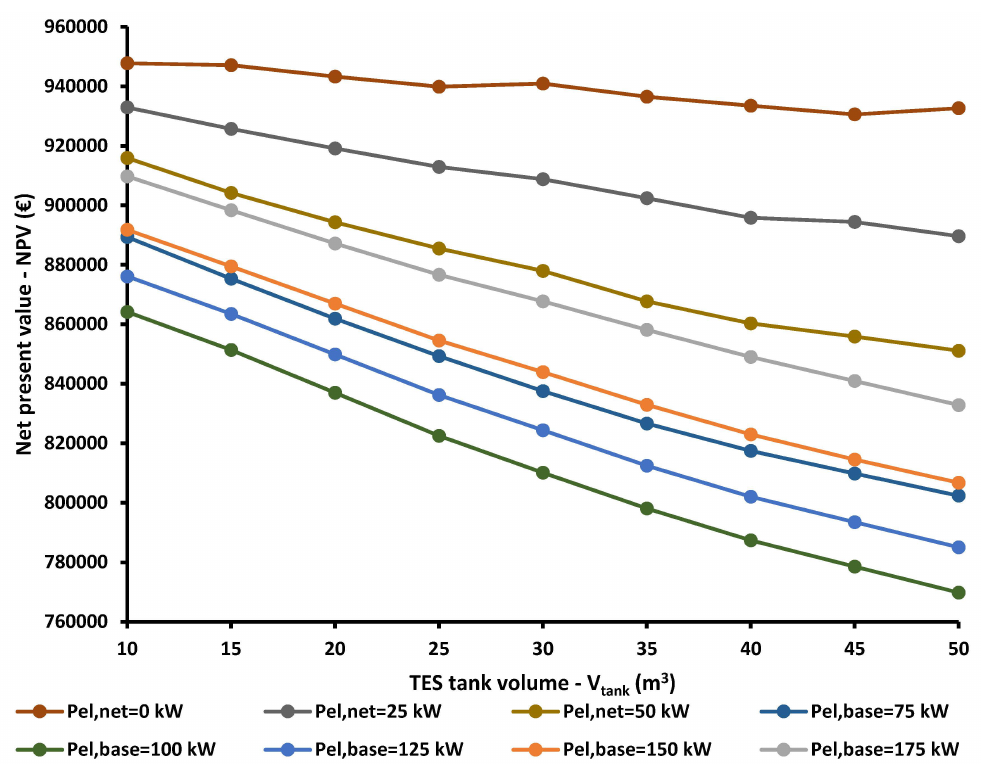
Figure 13. Net present value for different values of net electricity load and TES tank volume when the hydrogen price is equal to 20 EUR/kg.